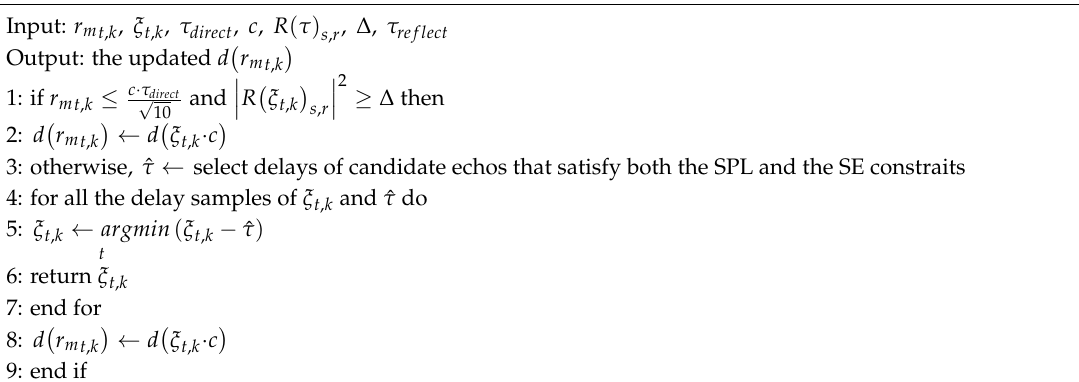
Algorithm 1. Algorithm for Updated First-Order Echo